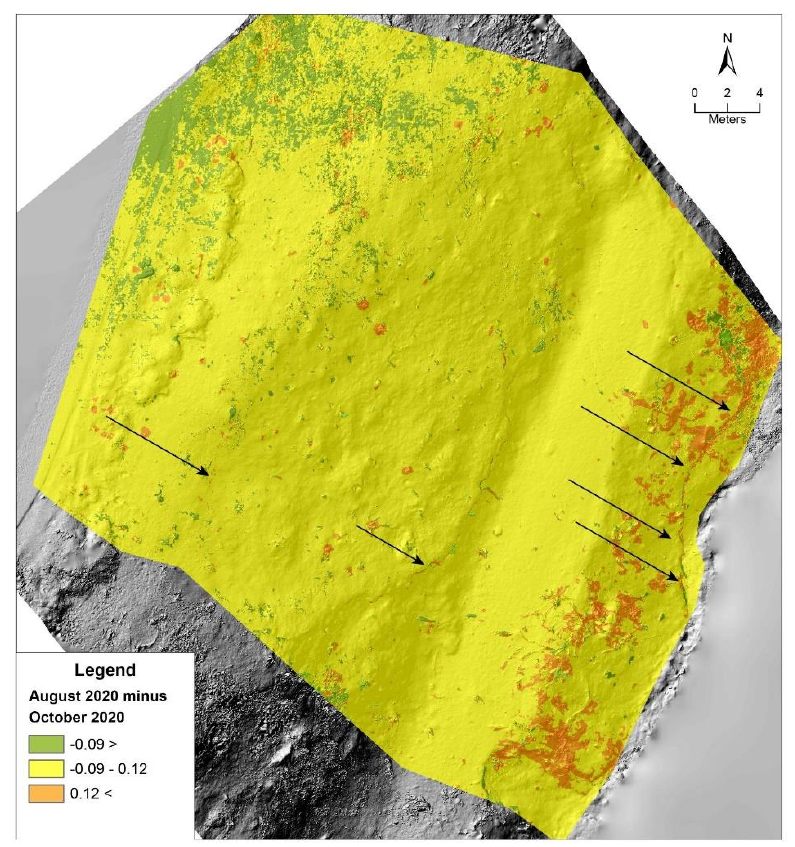
Figure 5. Differences between the August 2020 and the October 2020 UAV–derived DSMs from Kechries site one: A clear activation of a curved scarp is visible in the eastern part of the slope, and possible cracks are visible in the central and western parts of the slope. Black arrows indicate possible cracks in the soil surface.